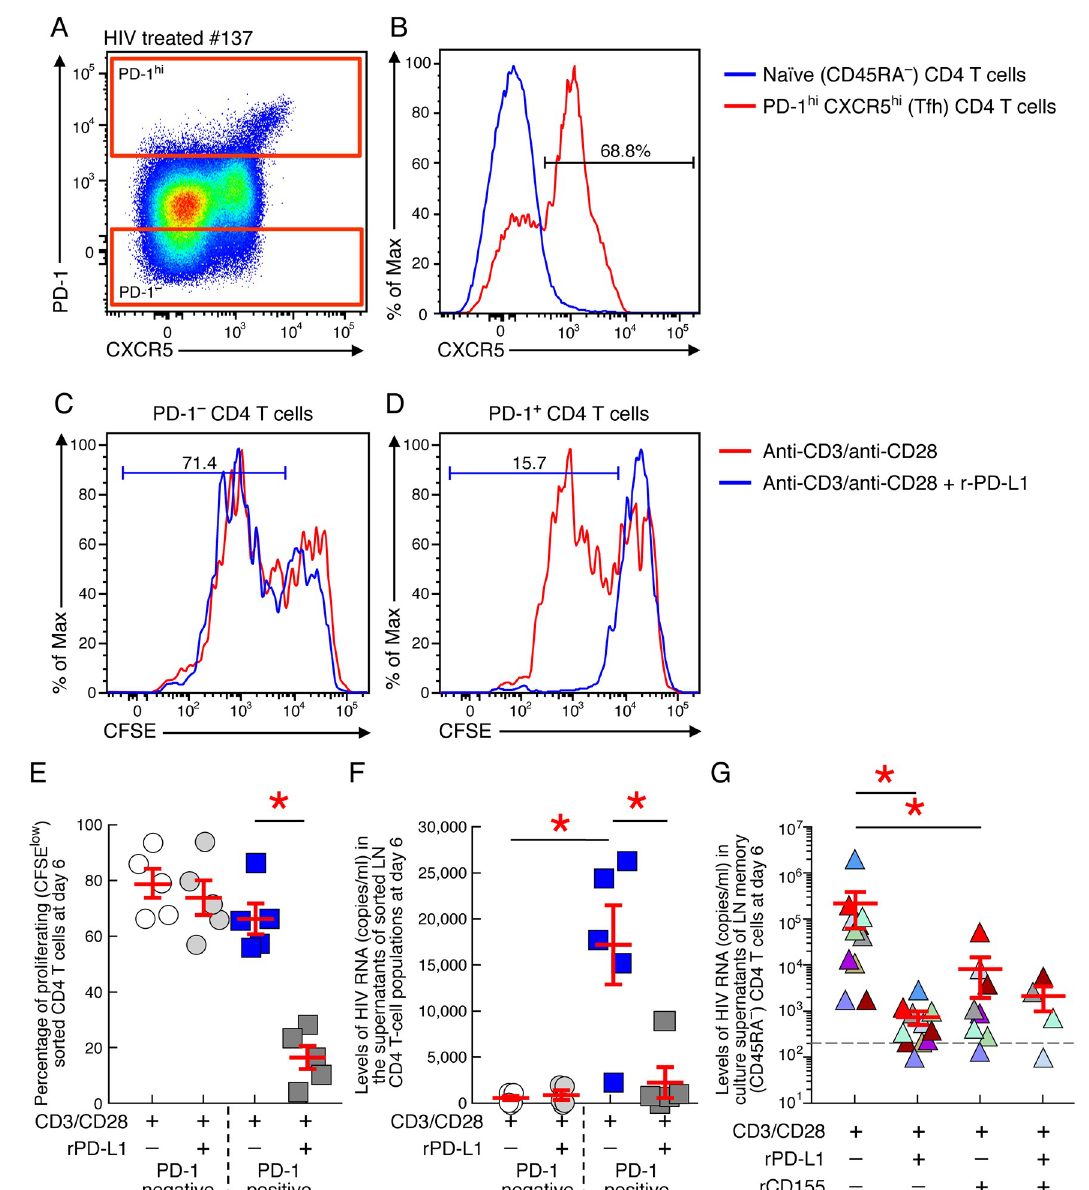
Fig 4. PD-1/PD-L1 interaction modulates HIV-1 transcription/production in LN of treated aviremic HIV-infected individuals. (A) Gating strategy used to sort LN PD-1 + and PD-1 - memory (CD45RA - ) CD4 T cells from one representative aviremic ART treated HIV-infected individual (#137). (B) Representative flow cytometry profile of LN memory (CD45RA - ) PD-1 + CD4 T cells expressing CXCR5 of one aviremic ART treated HIV-infected individual (#137). Representative flow cytometry profile of proliferating (CFSE low) LN PD-1 - (C) and PD-1 + (D) CD4 T cells following anti-CD3/anti-CD28 stimulation in the presence or in absence of recombinant PD-L1 protein of one aviremic ART treated HIV-infected individual (#137). (E) Cumulative data of the percentage of proliferating (CFSE low) LN PD-1 - and PD-1 + CD4 T cells following anti-CD3/anti-CD28 stimulation in the presence or in absence of recombinant PD-L1 protein of aviremic ART treated HIV-infected individuals (N = 5). (F) Cumulative data of the levels of HIV-1 RNA (copies/ml) in the culture supernatants at day 6 of LN PD-1 - and PD-1 + CD4 T cells following anti-CD3/anti- CD28 stimulation with emtricitabine in presence or in absence of recombinant PD-L1 protein of aviremic ART treated HIV-infected individuals (N = 5). (G) Cumulative data of the levels of HIV-1 RNA (copies/ml) in the culture supernatants at day 6 of sorted LN memory (CD45RA - ) CD4 T cells following anti-CD3/anti-CD28 stimulation in the presence or in absence of recombinant CD155 and/or PD-L1 proteins of aviremic ART treated HIV-infected individuals (N = 10). Circles represent sorted LN PD-1 - CD4 T cells and squares represent sorted LN PD-1 + CD4 T cells (E-F) . Red bars correspond to mean ± SEM (E-G) . Red stars indicate statistical significance ( P < 0.05). Statistical significance ( P values) was obtained using one-way ANOVA (Kruskal-Wallis test) followed by ratio Paired-t test ( E-G ).